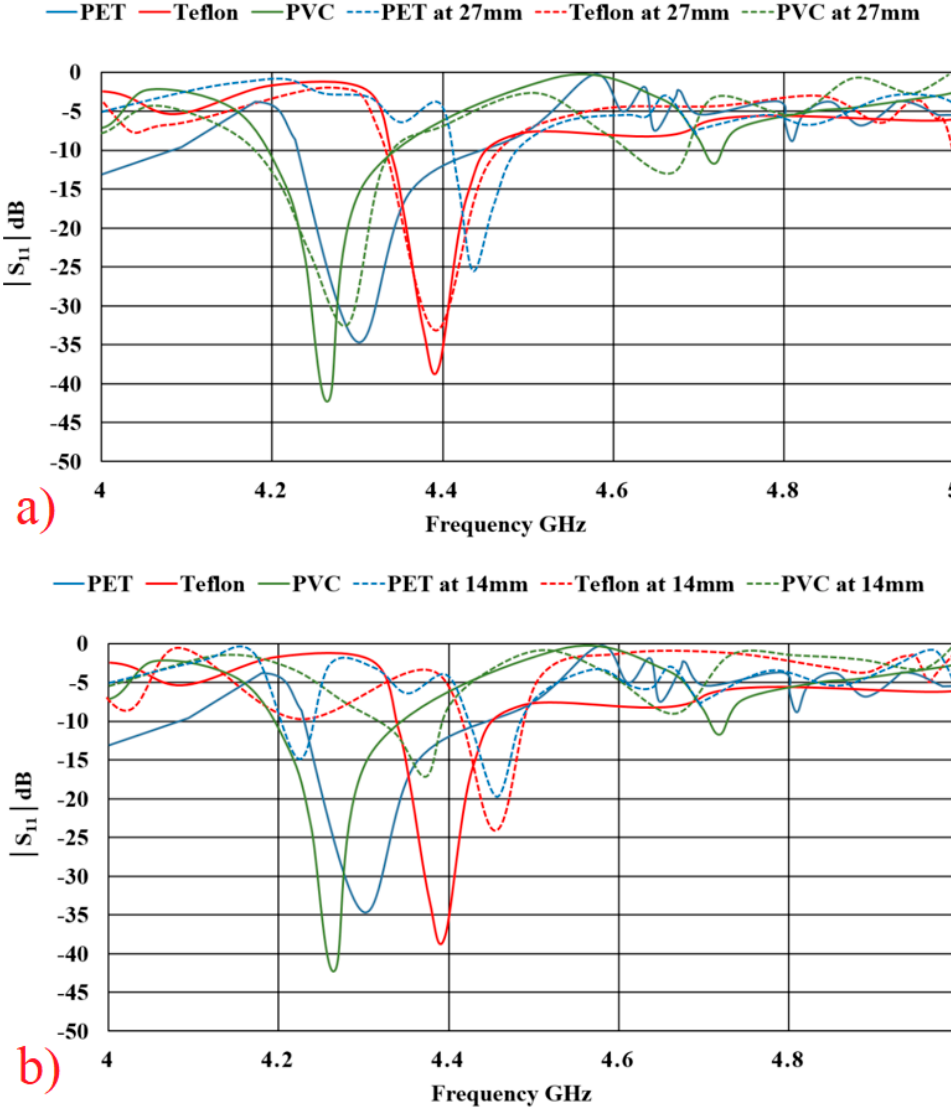
Figure 14. Operating at 4.25 GHz, reflection coefficients of E-shaped flexible polymer substrate antennas on PET, Teflon, and PVC substrates non-bent and with bending: ( a ) 27 mm, ( b ) 14 mm.